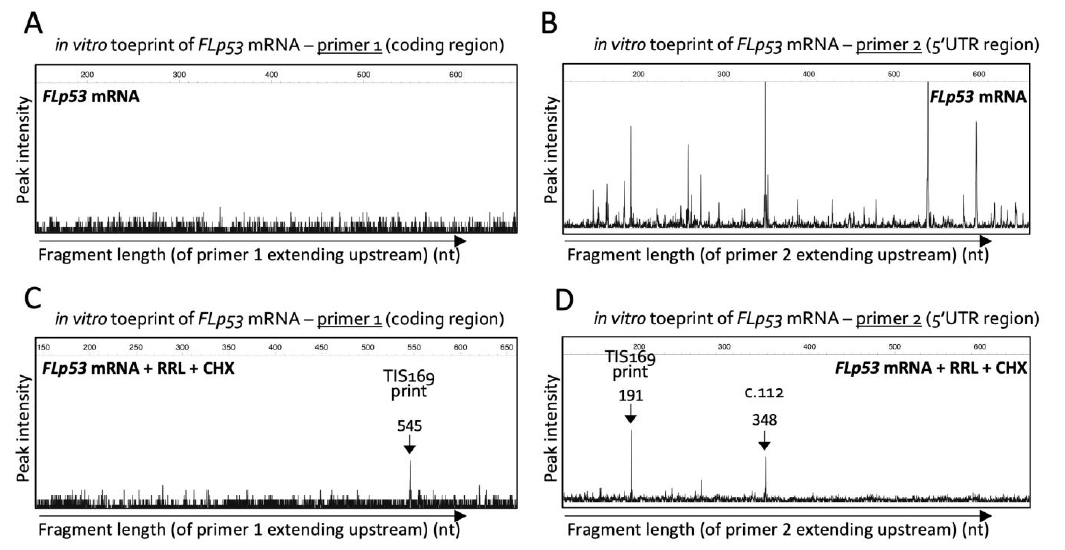
Figure 1. Ribosomal toeprints at AUG169 of in vitro transcribed FL p53 mRNA observed in the presence of rabbit reticulocyte lysates (RRL) and cycloheximide